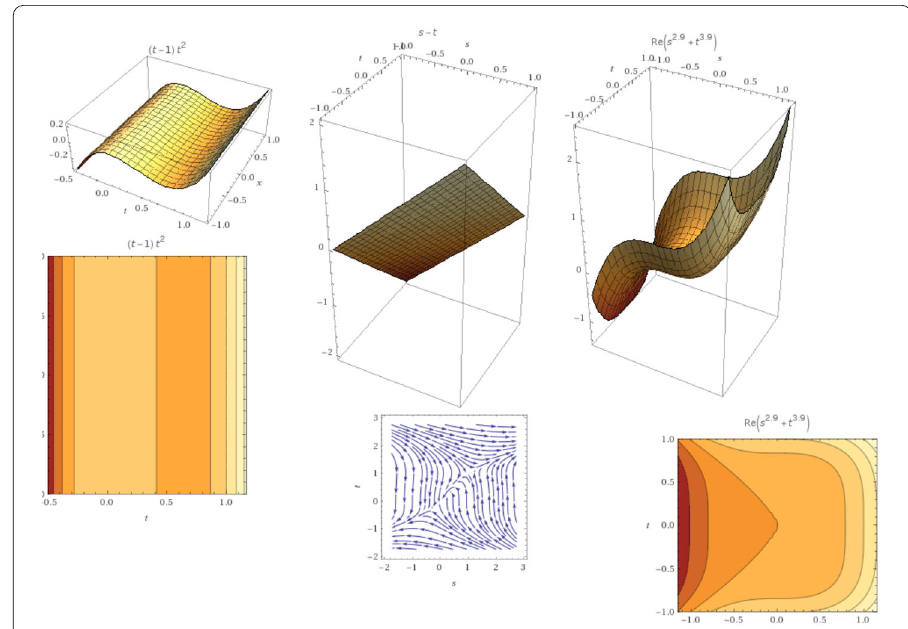
Figure 6 GB for the nonlinear case { τ 3 – τ 2 , ς – τ } with the fractional case when μ = 0.9